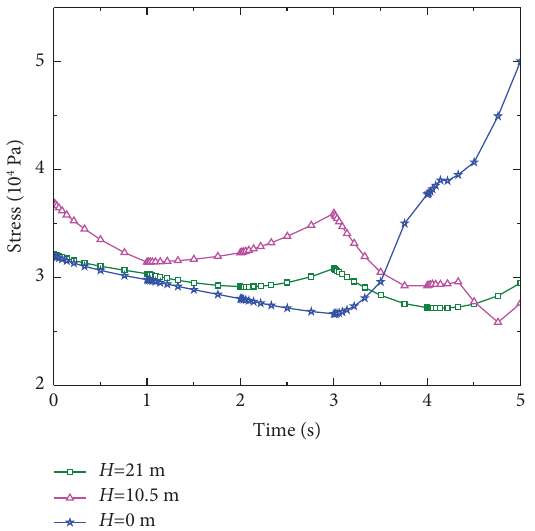
Figure 13: Change curve of soil stress with time at diferent po- sitions of the